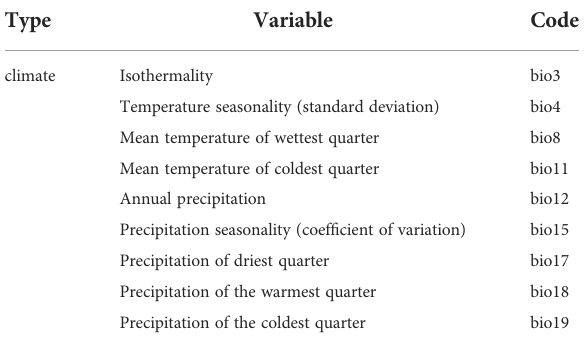
TABLE 1 Description of environmental variables used in